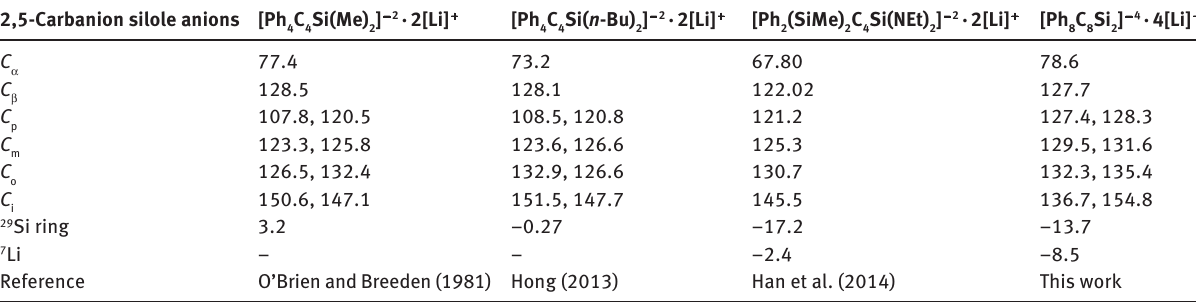
C Si(Me) ] − 2 · 2[Li] 4 4 2